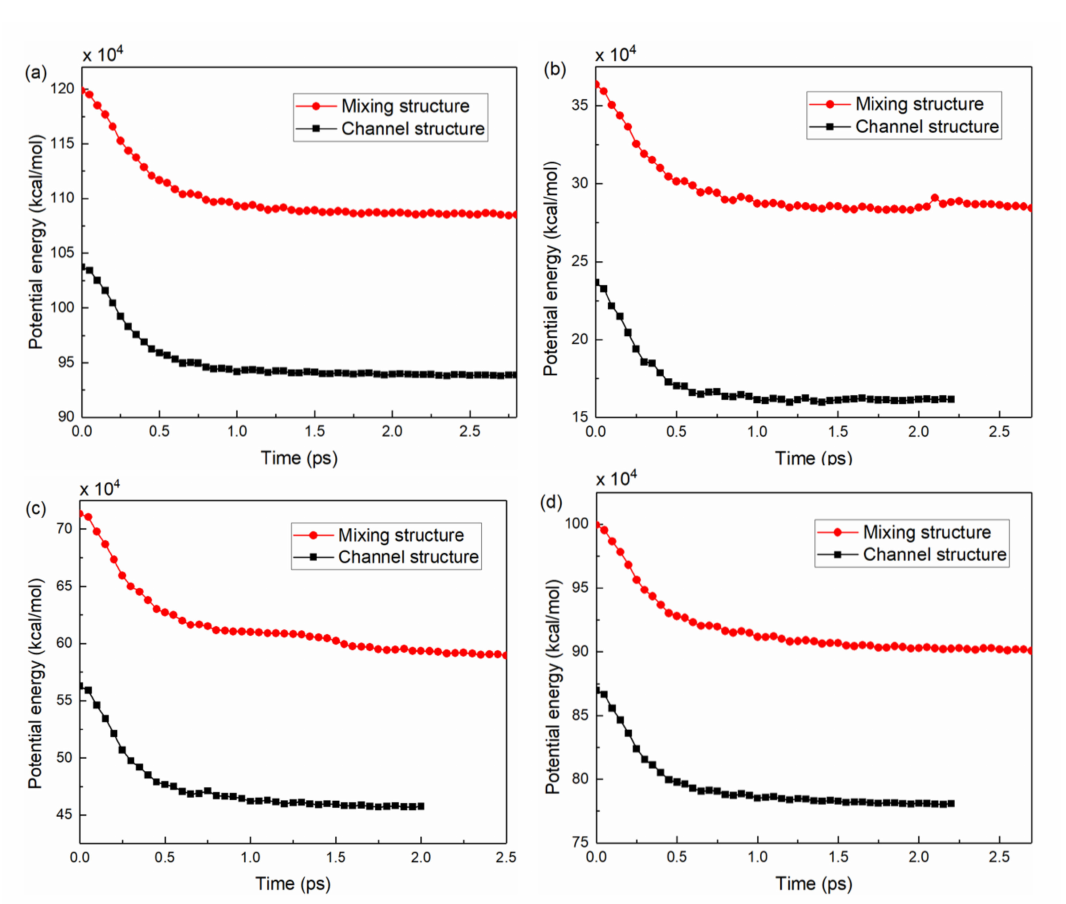
Figure 11. The potential energy of four polymers during the demolding process: ( a ) PC, ( b ) PMMA, ( c ) COC and ( d )